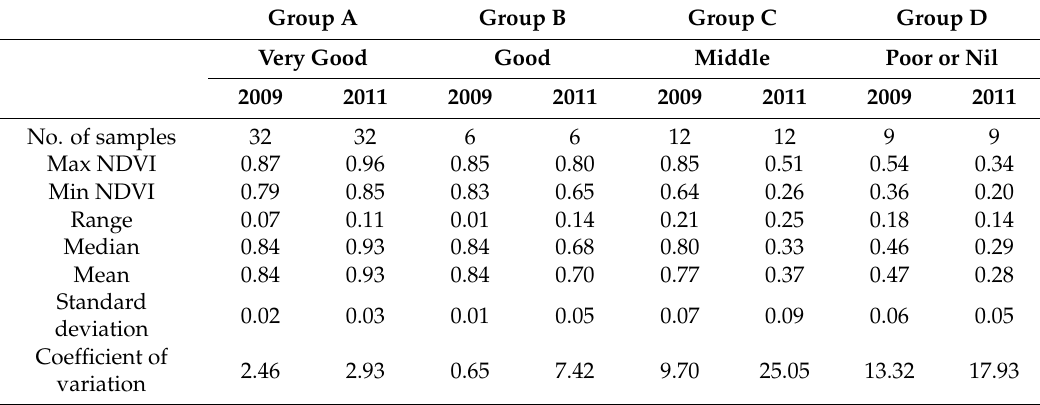
Table 4. Statistics of the four vegetative development groups (Very good, Good, Middle, and Poor or nil) established according to NDVI.